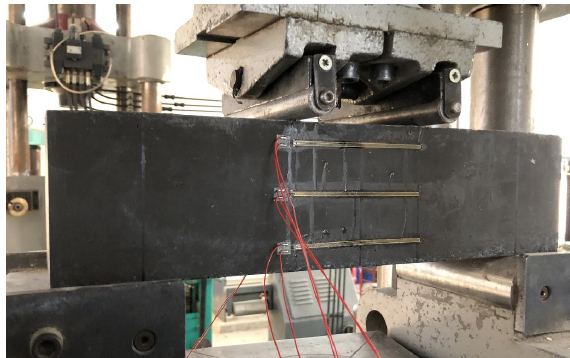
Figure 9. Physical map of the flexural tensile test.